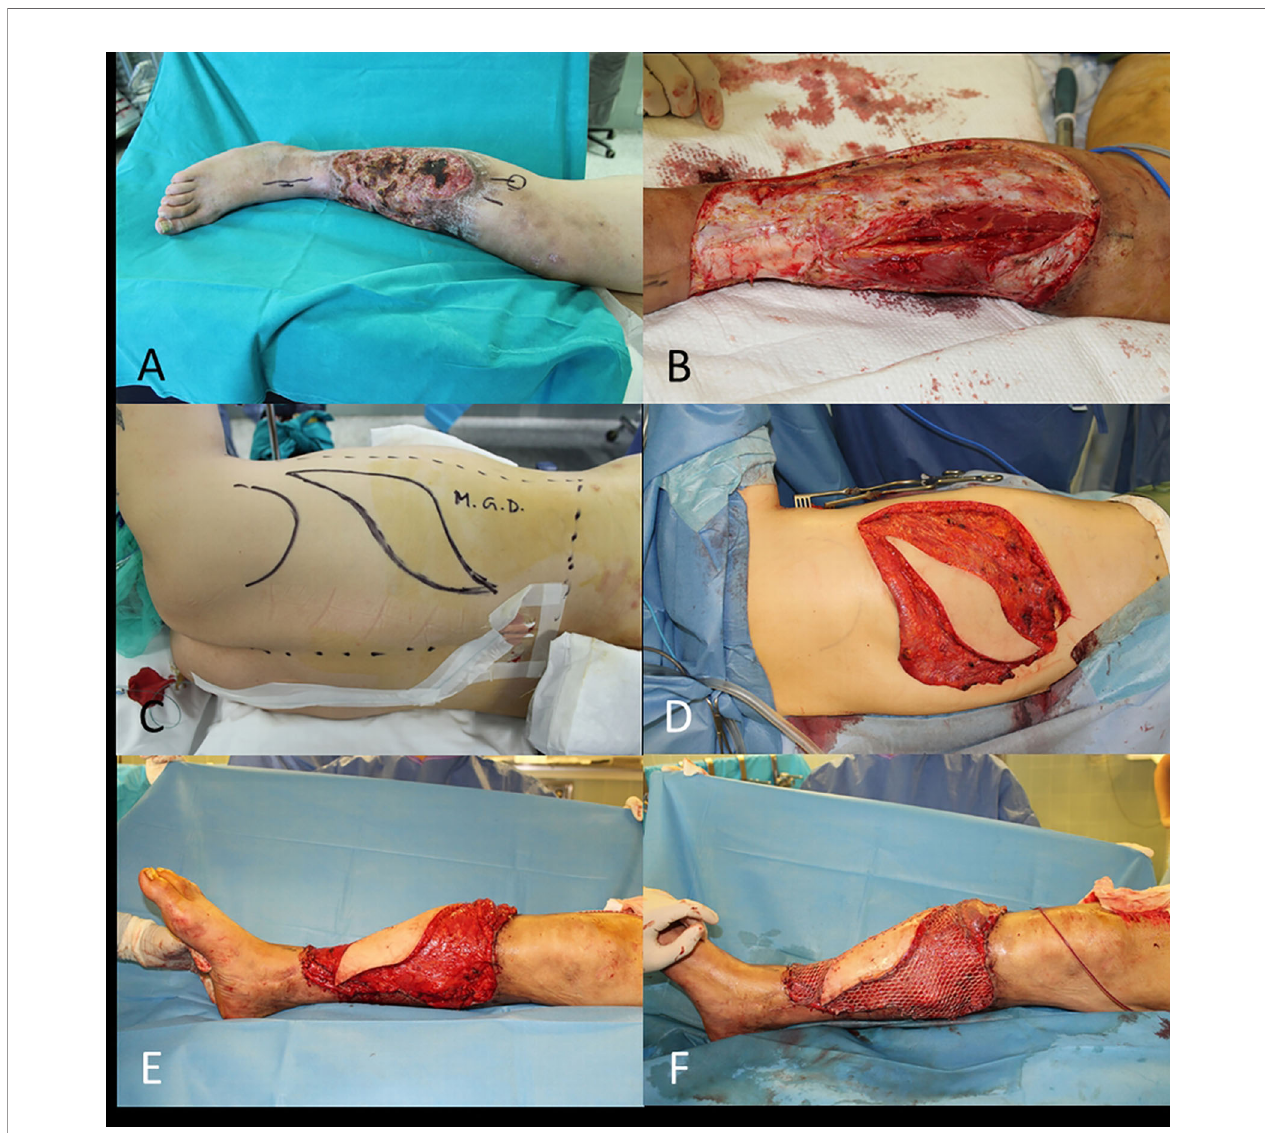
FIGURE 13 | (A) SCC of the leg; (B) End of WLE with bone exposure; (C) Free latissimus dorsi fl ap planned; (D) Flap ready for transfer; (E) End of microsurgical transplant; (F) Final result with skin